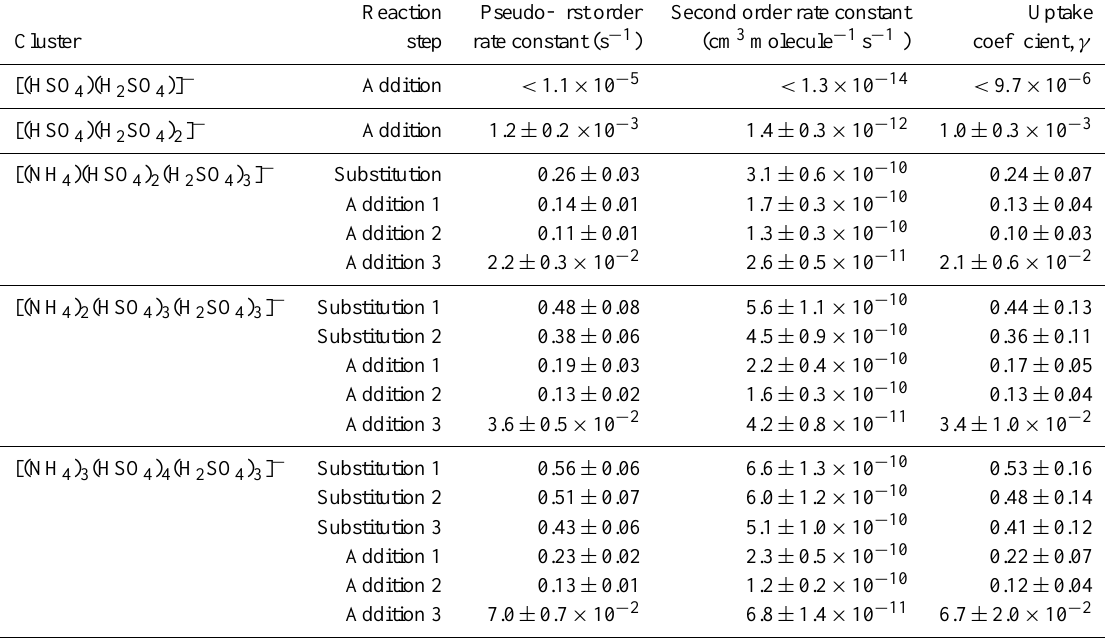
Table 1. Pseudo-first order rate constants, second order rate constants, and uptake coefficients for reaction of dimethylamine with negatively- charged ammonium bisulfate clusters ∗ .